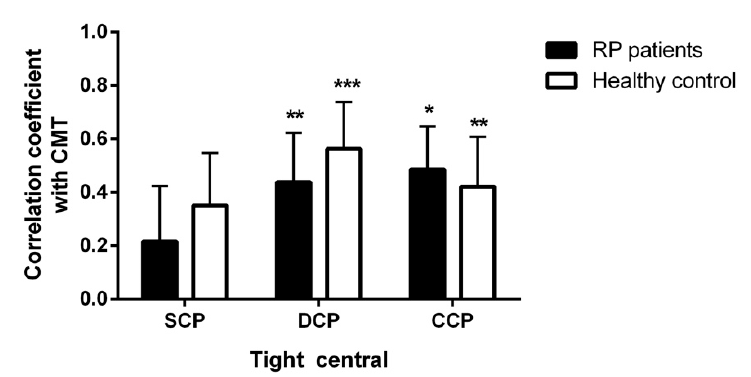
Figure 3. Pearson’s correlation coefficients between PD of the tight central ring in SCP, DCP and CC and CMT in RP patients and healthy controls. Error bar represent standard error of coefficient. * p < 0.05; ** p < 0.001 and *** p < 0.001.